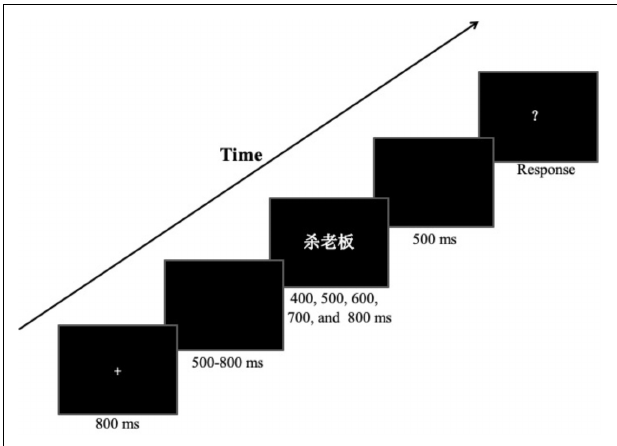
FIGURE 1 | Schematic illustration of a trial procedure used in the experiment.